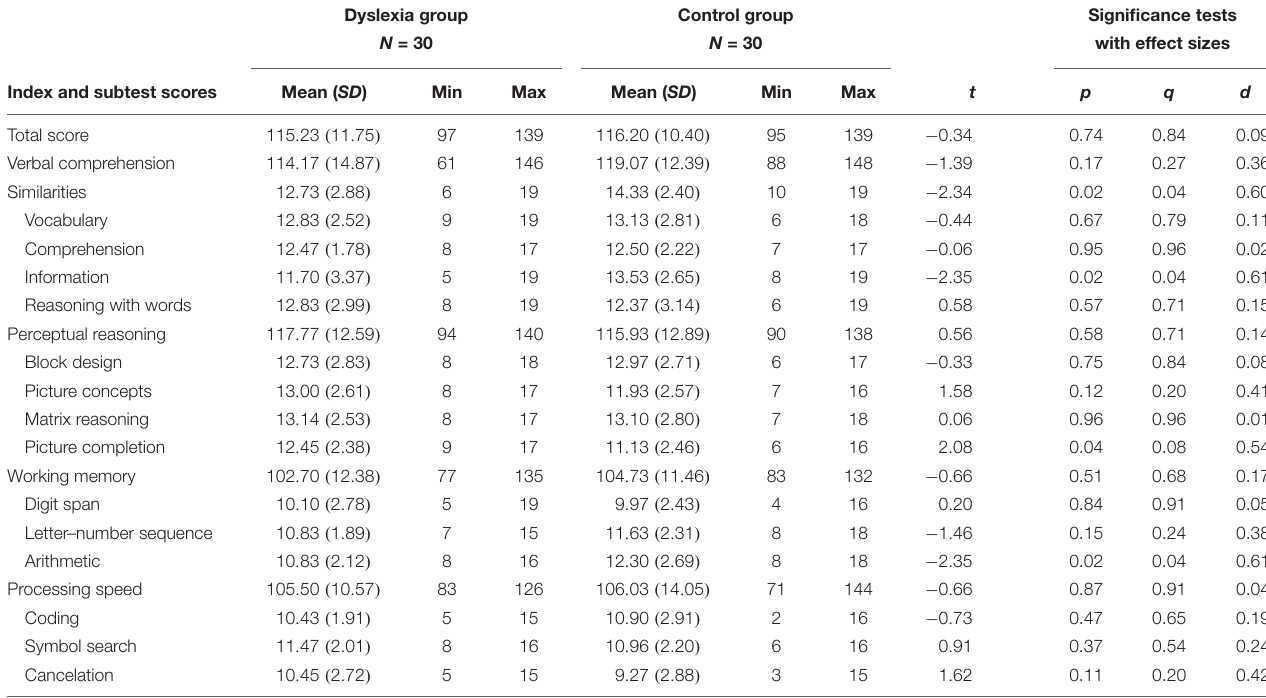
TABLE 1 | Mean standard scores ( SD ) with minimum and maximum scores on the WISC-IV measures according to group, with significance tests and effect sizes. Dyslexia group Control